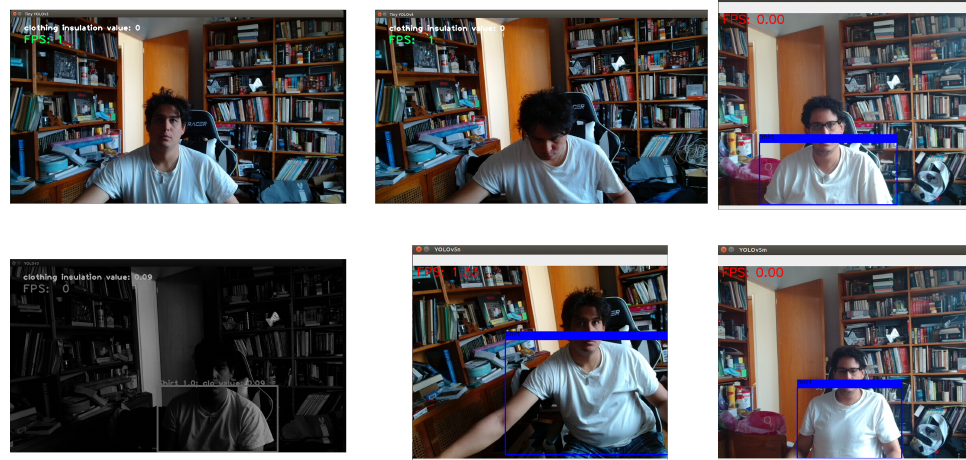
Figure 13. Jetson Nano